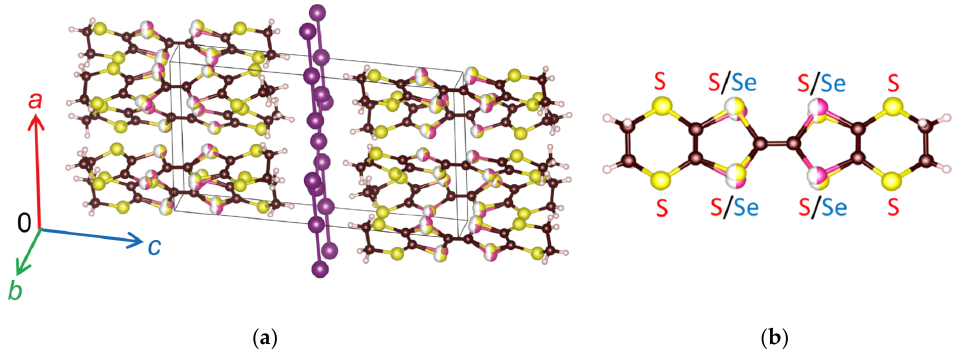
Figure 1. Crystal and molecular structures of α -D 2 I 3 (D = ET, STF and BETS): ( a ) Crystal structures shared by α -ET 2 I 3 , α -STF 2 I 3 and α -BETS 2 I 3 . The actual figure shown above is that of α -STF 2 I 3 . The structures of the other two complexes may be visualized by the symmetric substitution of the inner chalcogen atoms by S or Se; ( b ) Disordered S and Se atoms in the inner chalcogen atoms in the STF molecules (S:Se = 50%:50% at all the STF sites). Yellow, white-and-red, brown, blank and violet spheres denote S, Se, C, H and I atoms, respectively.